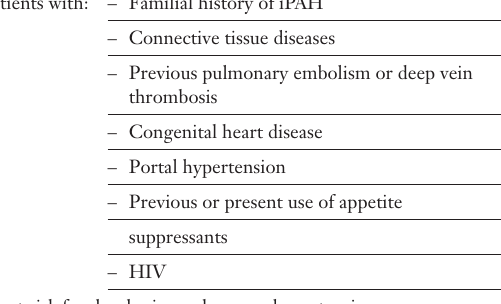
Patients with: – Familial history of iPAH